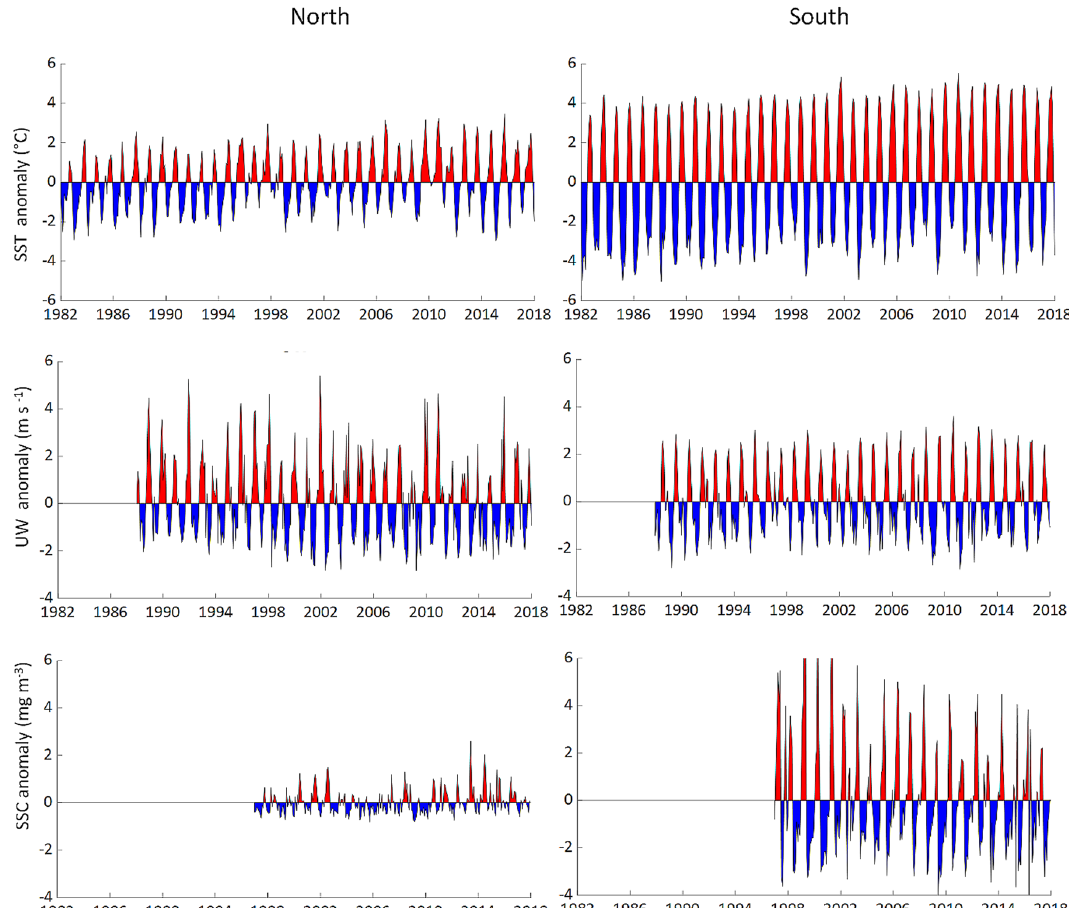
Figure 3. Monthly mean anomalies for (top) sea surface temperature (SST, °C); (middle) favorable upwelling wind (UW, m s −1 ), and (down) sea surface chlorophyll- a concentration (SSC, mg m −3 ) over the south part of the Canary Current Large Marine Ecosystem, split into the areas north of Cap Blanc (left) and south of Cap Blanc